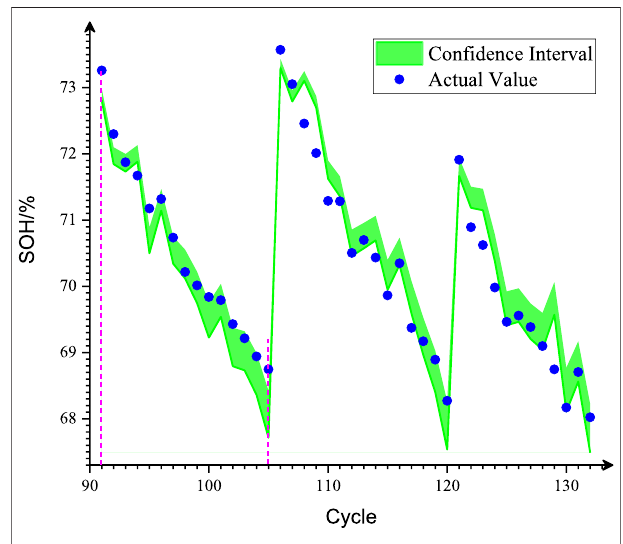
FIGURE 8 | Uncertainty expression of SOH prediction results of